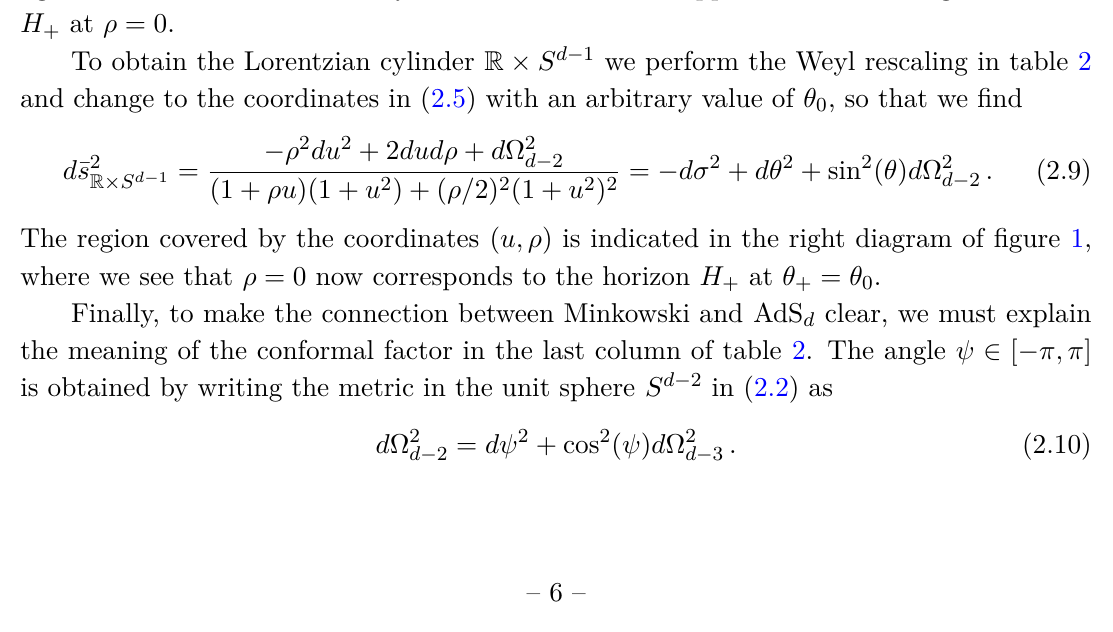
figure 1. The future null infinity of Minkowski I + is mapped to the cosmological horizon H at ρ = 0 +